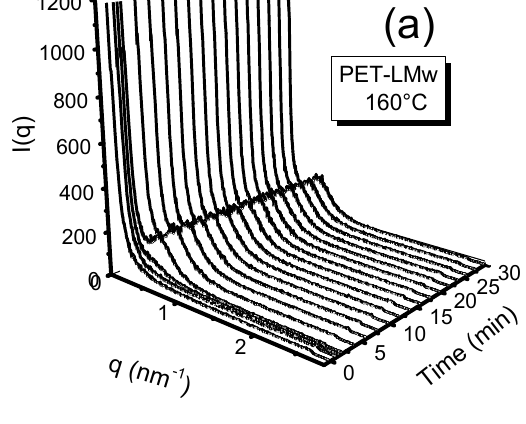
Figure 12. ( a ) Time-resolved SAXS patterns of isothermally crystallized (30 min) PET-LMw at different temperatures; Evolution of morphological parameters ( L , l a and l c) ( b ) PET-LMw; and ( c ) PET-HMw. Data were obtained from time resolved SAXS